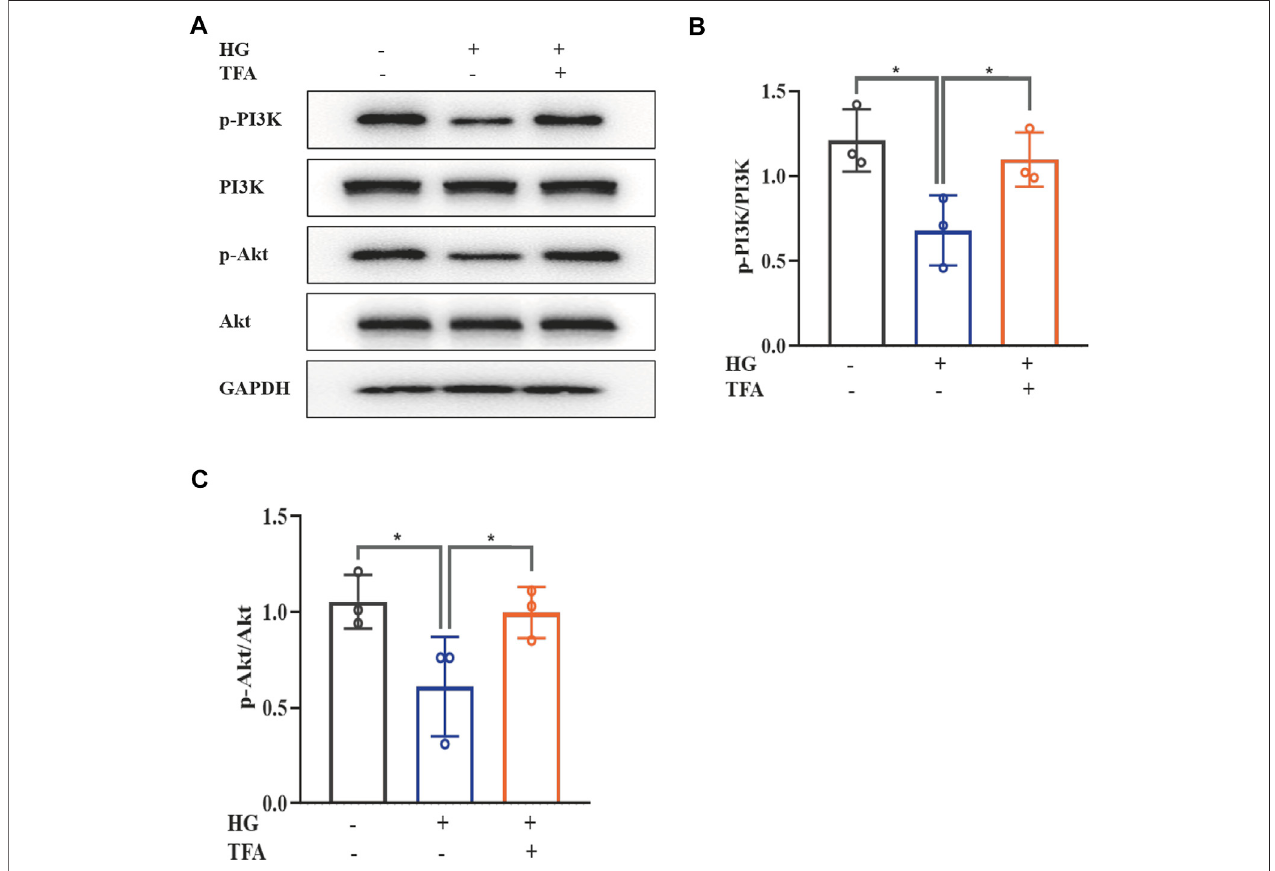
FIGURE 4 | TFA activated the PI3K/Akt signaling pathway in HG-af fl icted MPC-5 cells. (A) WB analysis of p-PI3K, PI3K, p-Akt, and Akt, in cultured MPC-5 cells exposed to HG at 30 mM for 48 h with or without TFA (20 μ g/ml) treatment for 24 h; (B) p-PI3K was quanti fi ed by densitometry; (C) p-Akt was quanti fi ed by densitometry. Data are expressed as mean ± S.D., ( n (cid:2) 3). * p < 0.05, ** p < 0.01. Abbreviations: TFA, total fl avones of Abelmoschus manihot ; PI3K, phosphatidylinositol 3-kinases; Akt, protein kinase B; HG, high glucose; MPC-5, mouse podocyte cell-5; WB, western blotting; p-PI3K, phosphorylated-phosphatidylinositol 3-kinase; p-Akt, phosphorylated-protein kinase